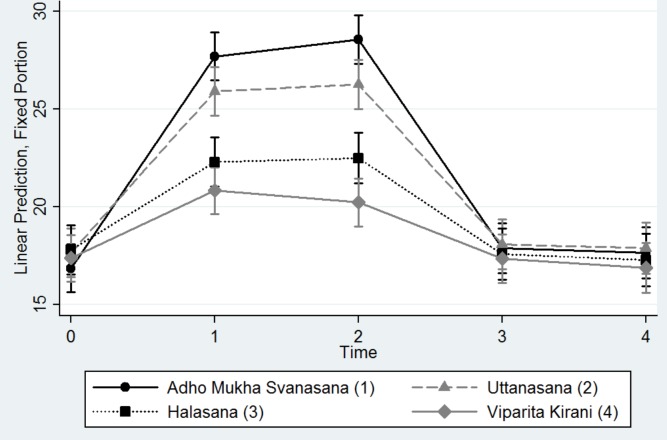
Predictive Margins of Yoga Pose versus Time with 95% Confidence Intervals.